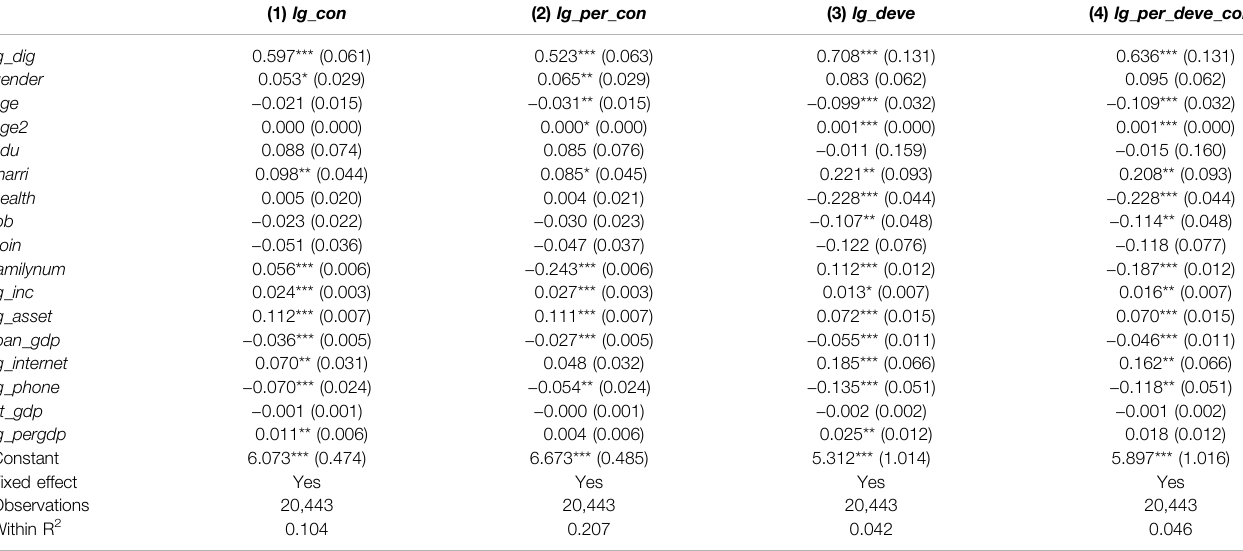
TABLE 2 | Impact of digital fi nancial inclusion on rural residents ’